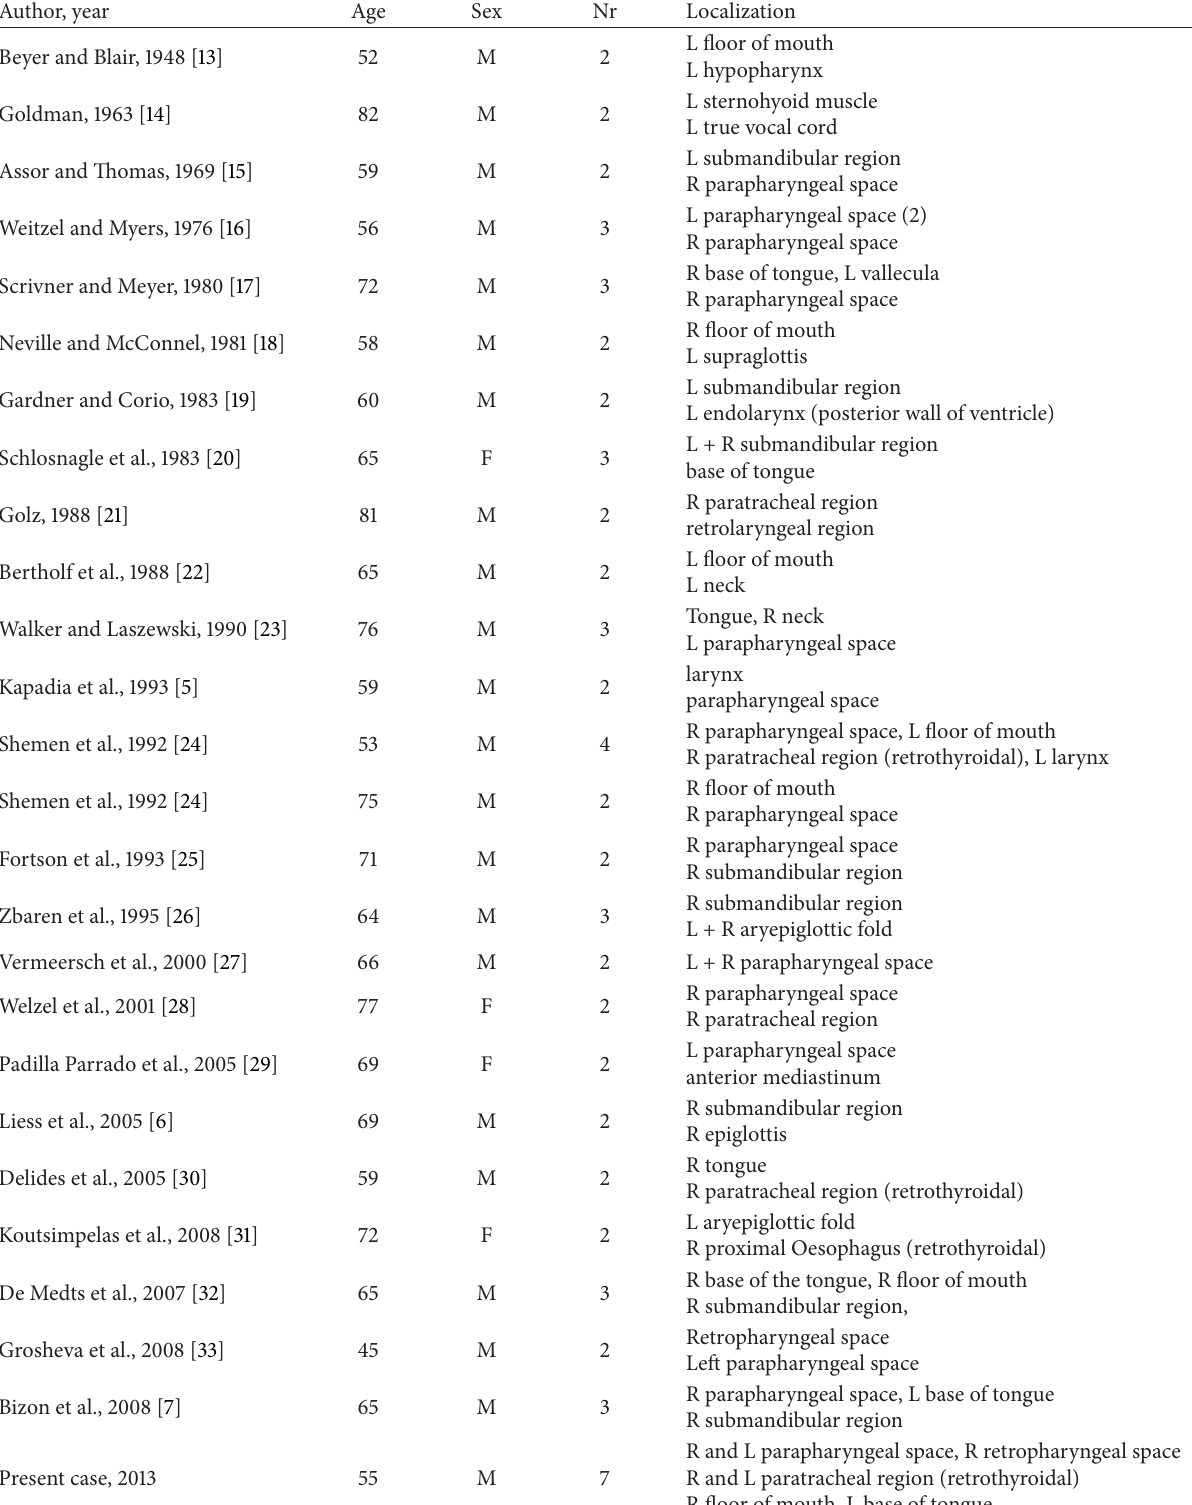
Table 1: Reported cases of multifocal ARM of the head and